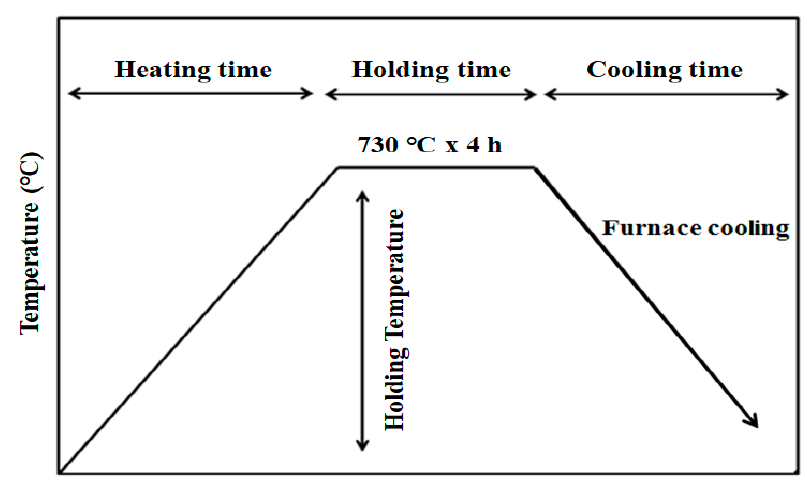
Figure 3. Schematic diagram of post weld heat treatment.